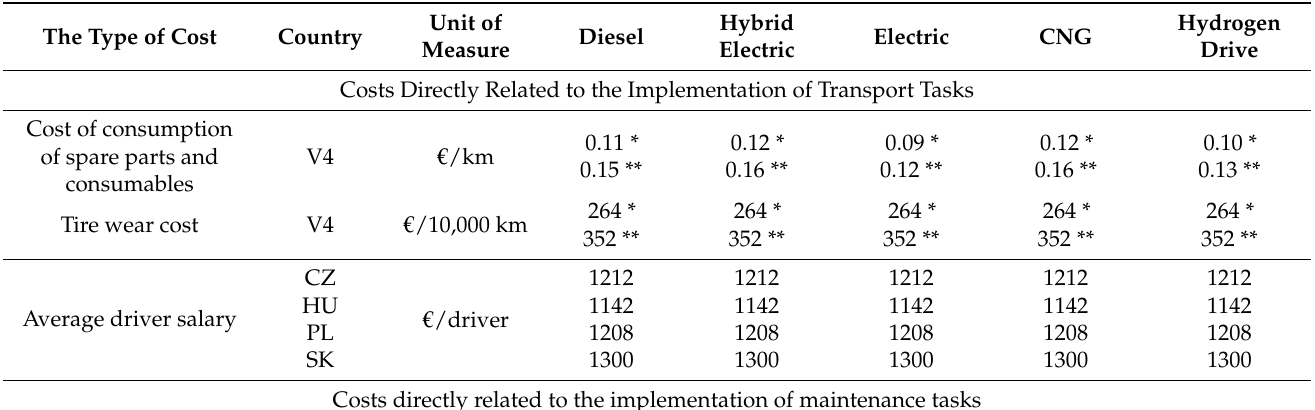
Table 7. Basic assumptions for unit operating costs in the operating period as of 1 July 2021 ( €